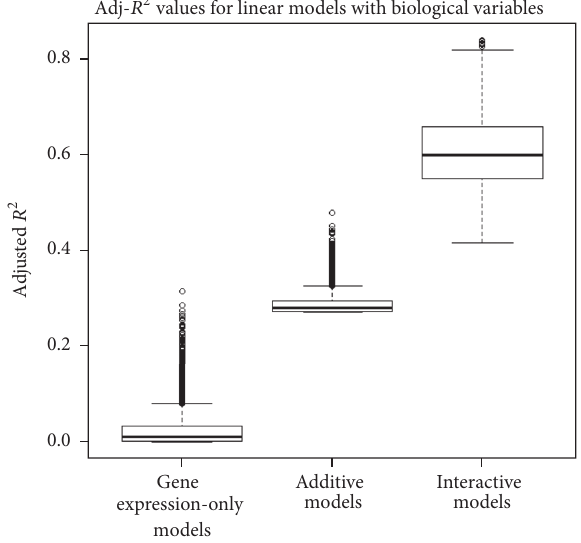
Figure 3: Adj- 𝑅 2 values for linear equations fitting SF2 on 48 cell lines. Adj- 𝑅 2 values increase systematically as more covariates are included in the linear